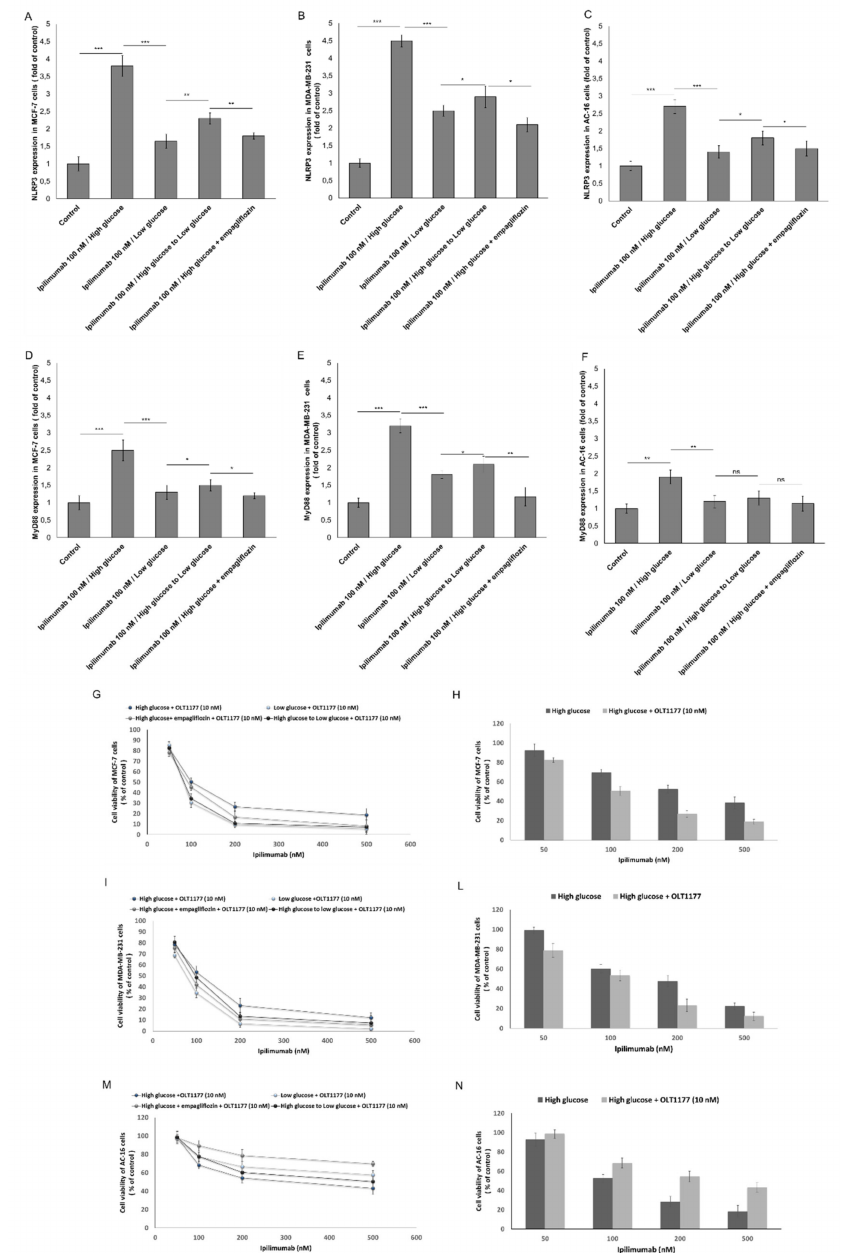
Figure 6. NLRP3 (fold of control) expression in MCF-7 ( A ), MDA-MB-231 ( B ), and AC-16 cells ( C ), treated with ipilimumab mAb in the presence of hPBMCs under di ff erent condition (high glucose; low glucose; high glucose + empagliflozin at 500 nM; shifting from a high glucose to low glucose). MyD88 (fold of control) expression in MCF-7 ( D ), MDA-MB-231 ( E ), and AC-16 cells ( F ), treated with ipilimumab in the presence of hPBMCs under di ff erent condition (high glucose; low glucose; high glucose + empagliflozin at 50 nm; shifting from a high glucose to low glucose). Cell viability of MCF-7 ( G , H ), MDA-MB-231 ( I , L ), and AC-16 cells ( M , N ) under high glucose (with or without empagliflozin), low glucose, shifting from high glucose to low glucose and always exposed to ipilimumab and NLRP3 selective inhibitor OLT-1177. For all experiments, untreated or treated cells with an unrelated control IgG (control) were used as negative controls. Error bars depict means ± SD ( n = 3). Statistical analysis was performed using paired t -test. *** p < 0.001. ** p < 0.01. * p <